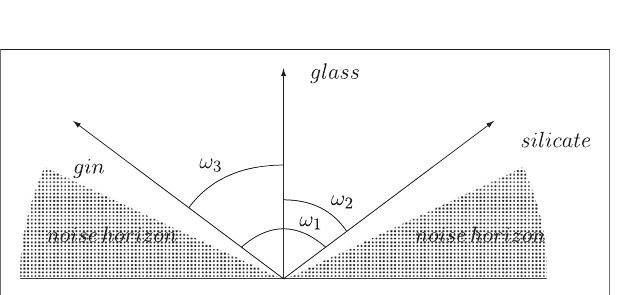
FIGURE 2 | Interestingness is not always